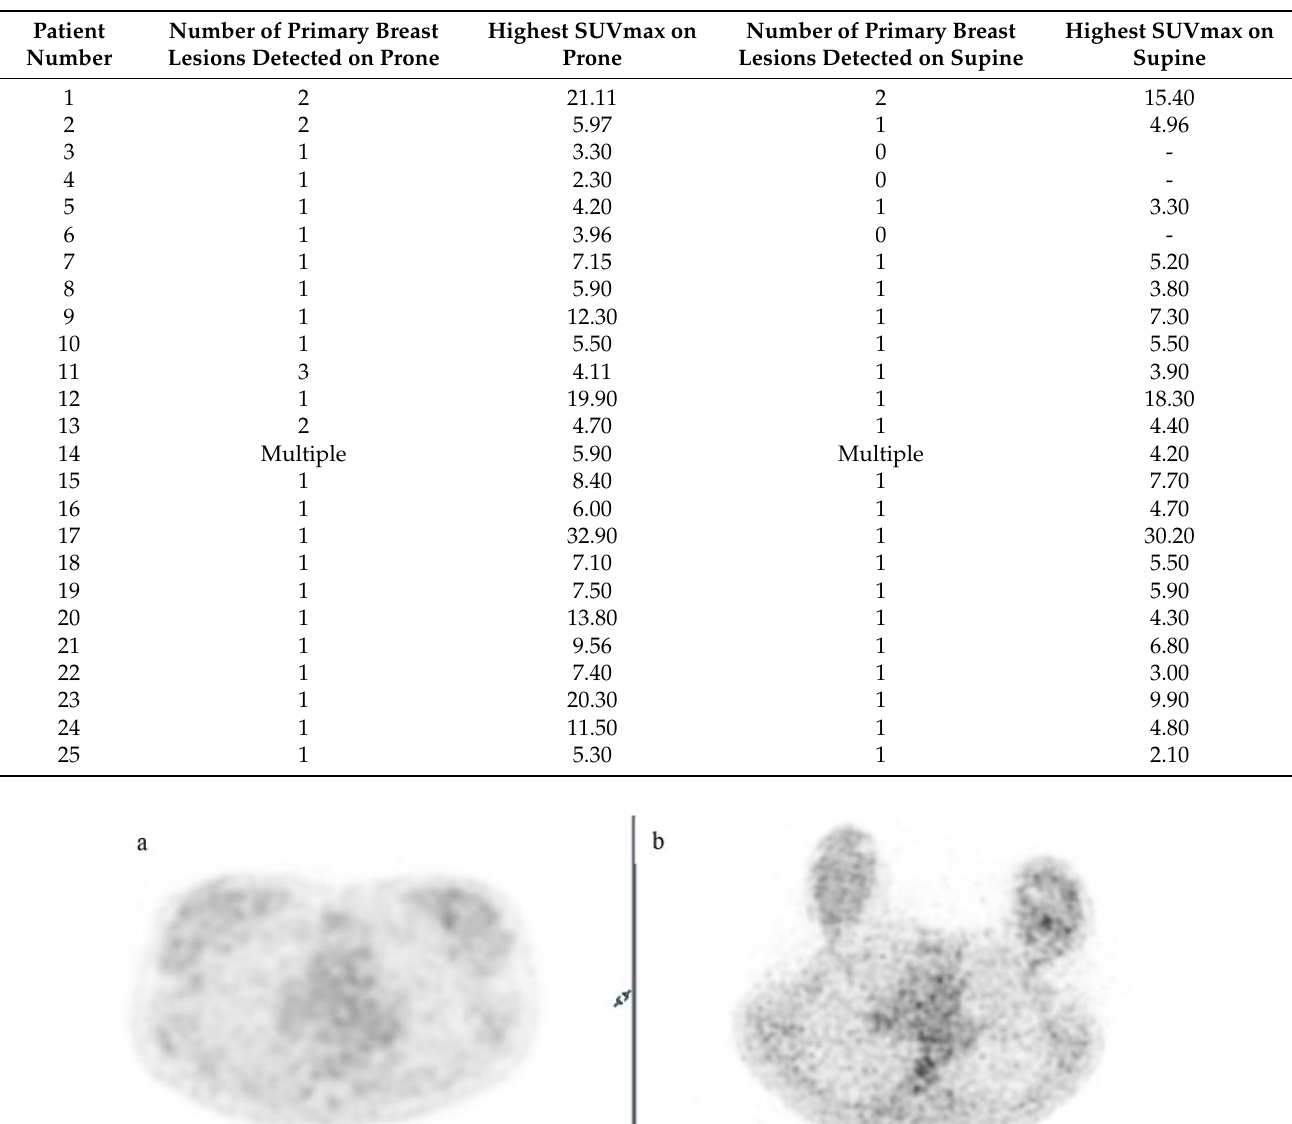
Table 1. Primary breast lesions detected on prone vs. supine.